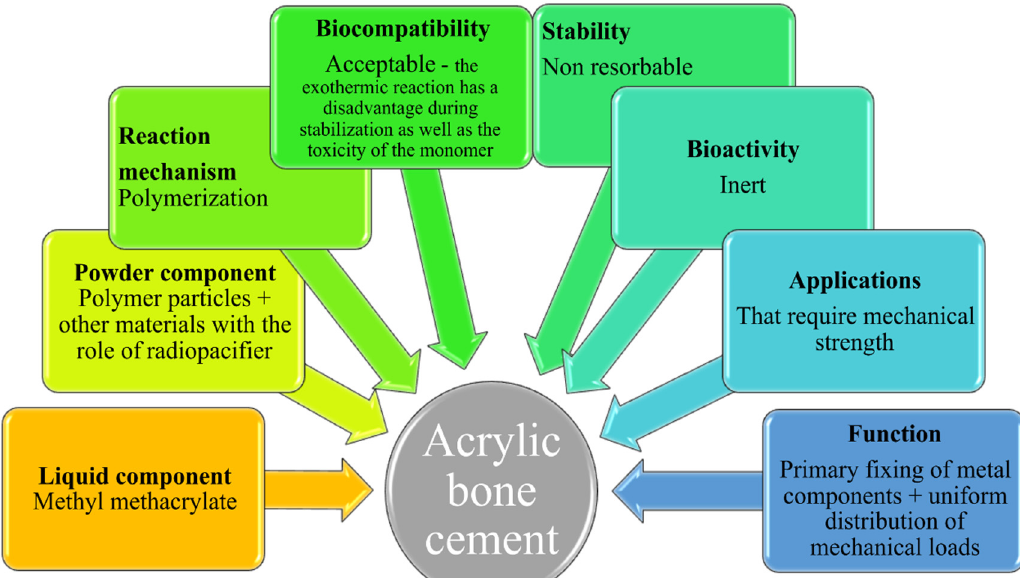
Figure 1. Schematic data of the acrylic bone cements.